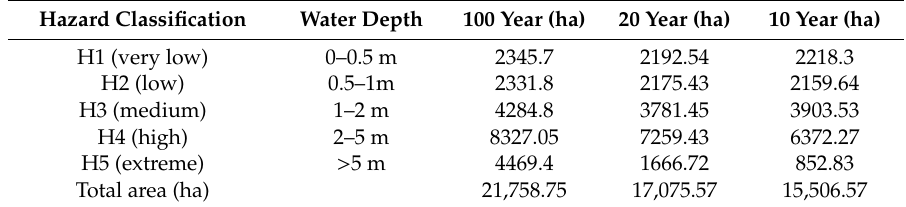
Figure 9. Hazard map (Classification 1) produced from the 10-year return period flow hydrograph. Table 5. Results of flood hazard classification (Classification 1) for each scenario.